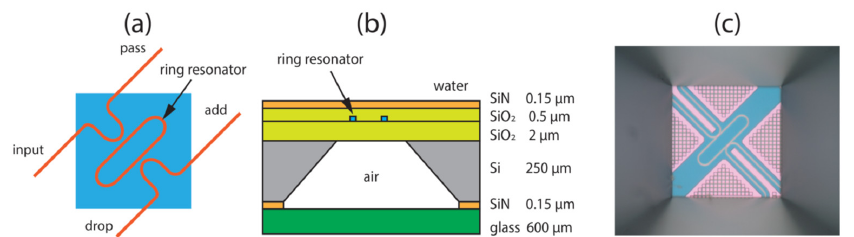
Figure 12. ( a ) Schematic of the RR ultrasound sensor: a RR on a square membrane (blue). ( b ) Cross- section of the membrane region, showing the various layers and their thickness. Membrane thickness is 2:65 µ m. A glass platelet seals the air cavity under the membrane. ( c ) Microscope image of the membrane with the RR, taken from below. The membrane size is 84 µ m × 84 µ m